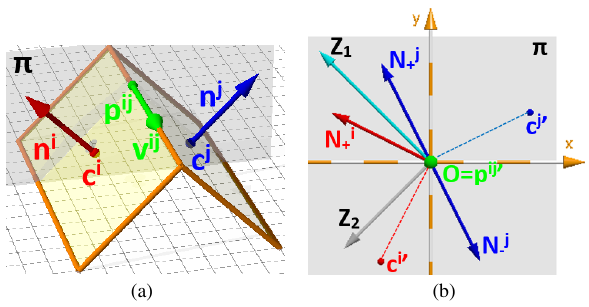
Figure 2. (a) Pair of planar facets i, j forming a gable roof. The direction vector v ij of the intersection line is perpendicular plane π ’s normal. Normal vectors and bounding box centroids of roof parts denoted by n i , n j and c i , c j . (b) Normal vectors with two orientations (+,-) and centroids projected onto π . Only averaging two normal vectors with ’positive’ orientation (according to the roof convexity c i (cid:48) Oc j (cid:48) ) will result in the proper Z axis estimate Z 1